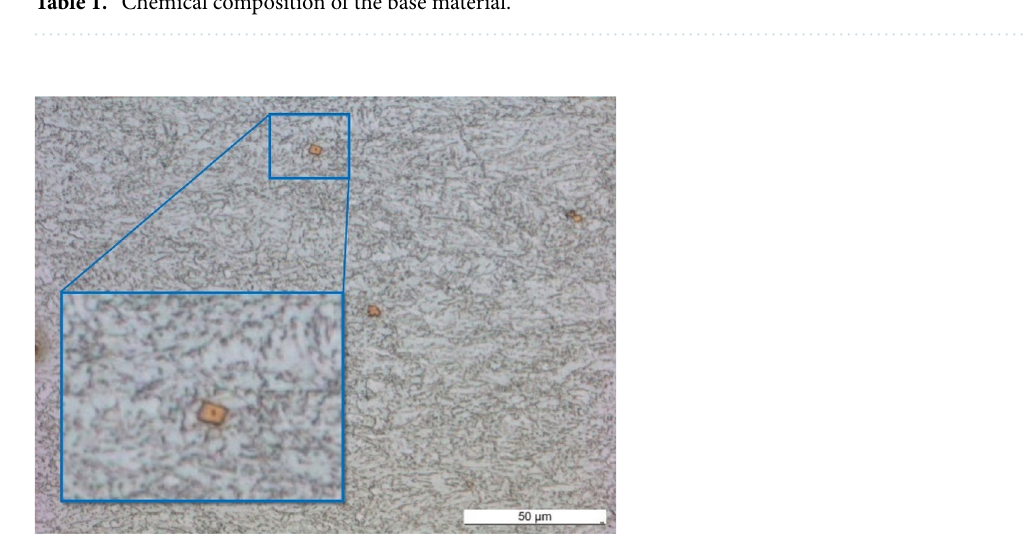
Table 1. Chemical composition of the base material.